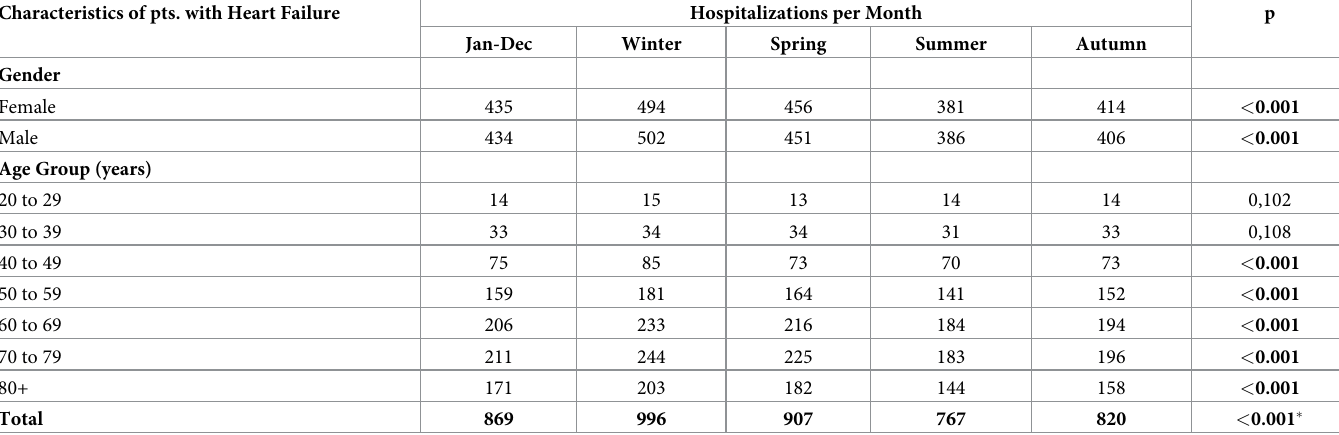
Table 1. Average number of hospitalizations per month for heart failure, per season, according to gender and age group. Characteristics of pts. with Heart Failure